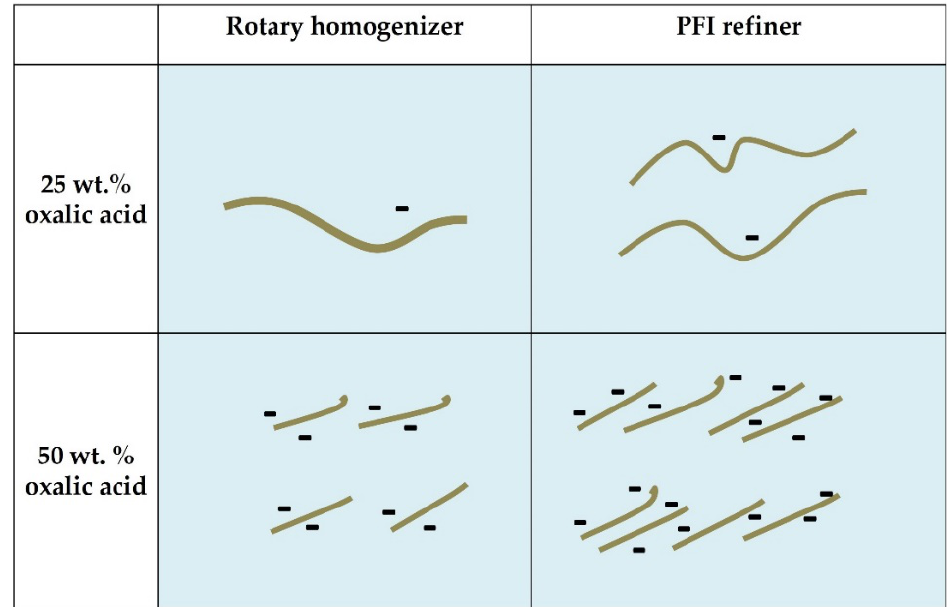
Figure 8. Schematic representation of CNF suspension obtained with different chemical and mechanical pre-treatments.